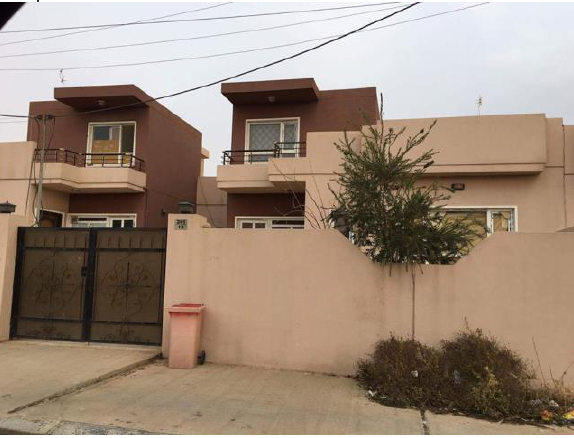
Figure 8. Front Garden of the houses in Goollun